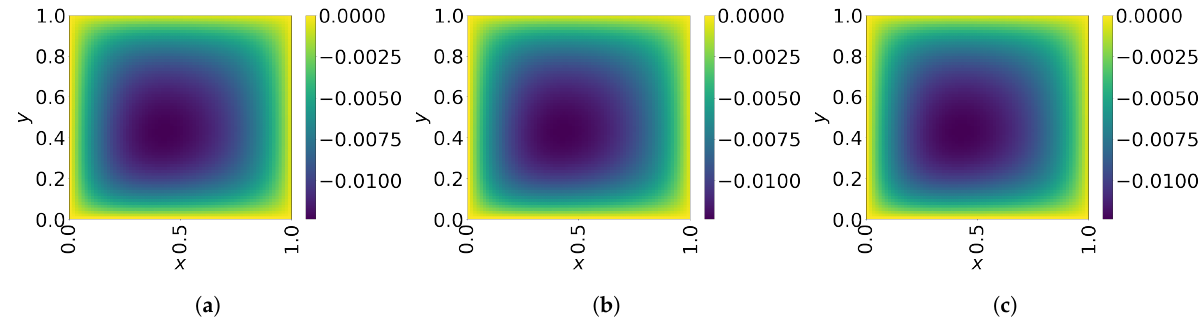
Figure 8. 2D linear diffusion equation. Solution snapshots of FOM, Galerkin ROM, and LSPG ROM at t = 2. ( a ): FOM, ( b ): Galerkin ROM, ( c ): LSPG ROM.